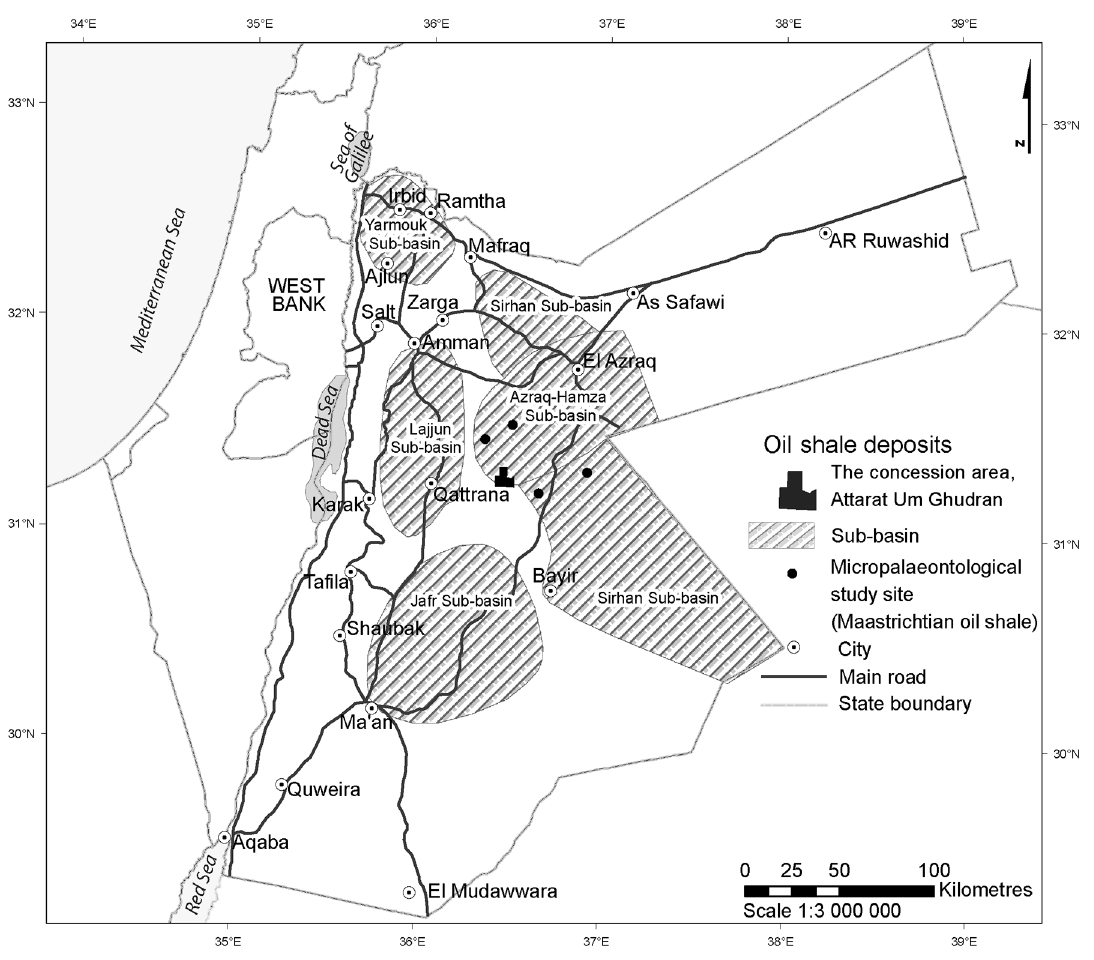
Fig. 1. Approximate location of the JOSE exploration area in the Late Mesozoic to Mid-Palaeogene epicontinental sea platform of Jordan, subjected to the formation of internal shelf basins structured by shallow swells; solid circles – micropalaeontological age studies of drill cores or cuttings (modified from Alqudah et al.